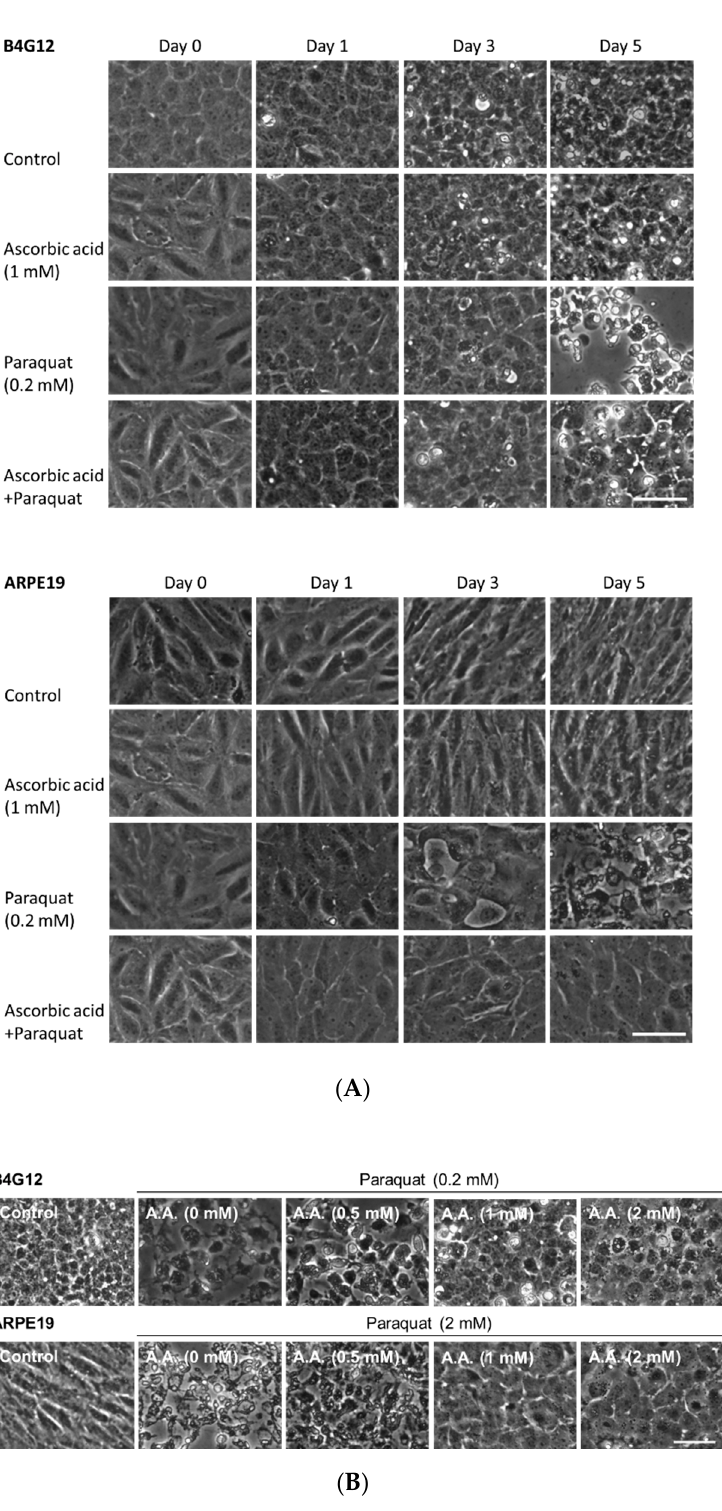
Figure 2. Ascorbic acid protects B4G12 and ARPE-19 cells from oxidative stress. B4G12 and ARPE-19 were pretreated with ascorbic acid (AA) for two days and further treated with paraquat (2 mM for ARPE-19, 0.2 mM for B4G12) for five days. ( A ) The time-dependent protective e ff ect of ascorbic acid (1 mM) on B4G12 and ARPE-19 cells was examined on days 0–5. ( B ) The dose-dependent protective e ff ect of ascorbic acid (0 to 2 mM) on B4G12 and ARPE-19 cells was examined on day five. Cell morphology was observed using phase-contrast microscopy, and images were captured at the same spot on di ff erent days. The scale bar represents 100 µ